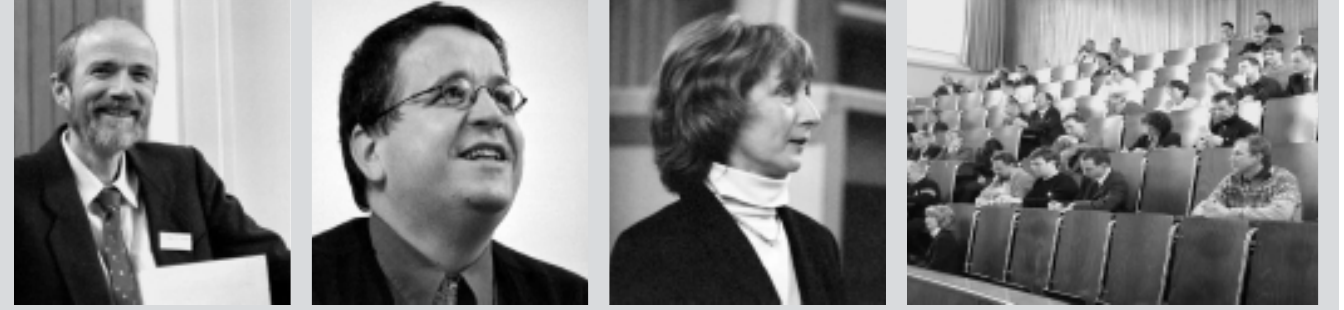
table. Mixing systems like the Tattersal rheome- ter or the Viskomat. Modified standard systems like the BML rheometer where cylinder, or cone- plate systems, are specially adopted. Finally sys- tems exist, where specially formed probes, like balls or cylinders, are moved through the mater- ial, measuring force and speed. Most of the over 20 presented systems, are a combination of